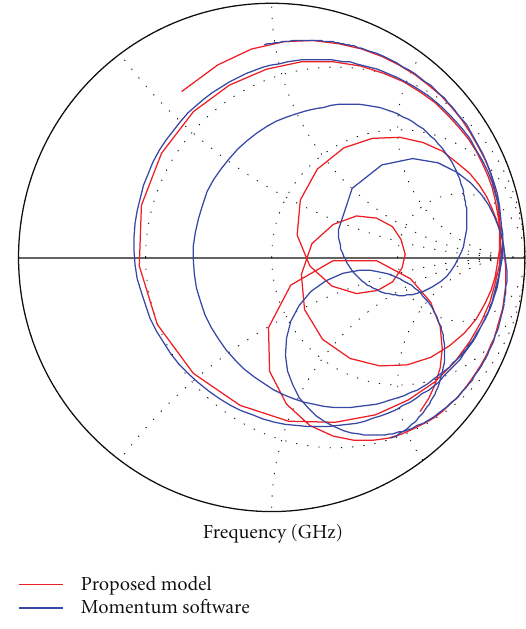
Figure 7: Smith’s chart of the input impedance return losses.